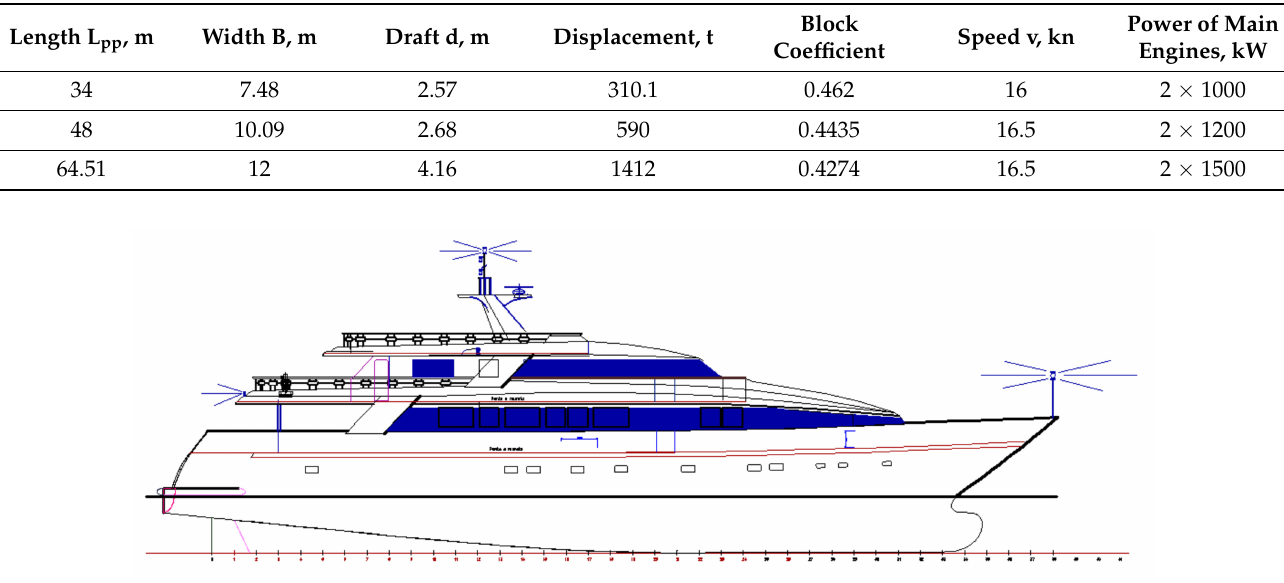
Table 1. The main dimensions of the yachts.